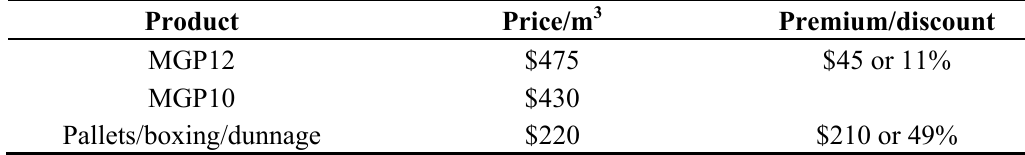
Table 2. Approximate prices (A$) for structural lumber for premium, framing and utility grades. The same premium/discount applies broadly to board